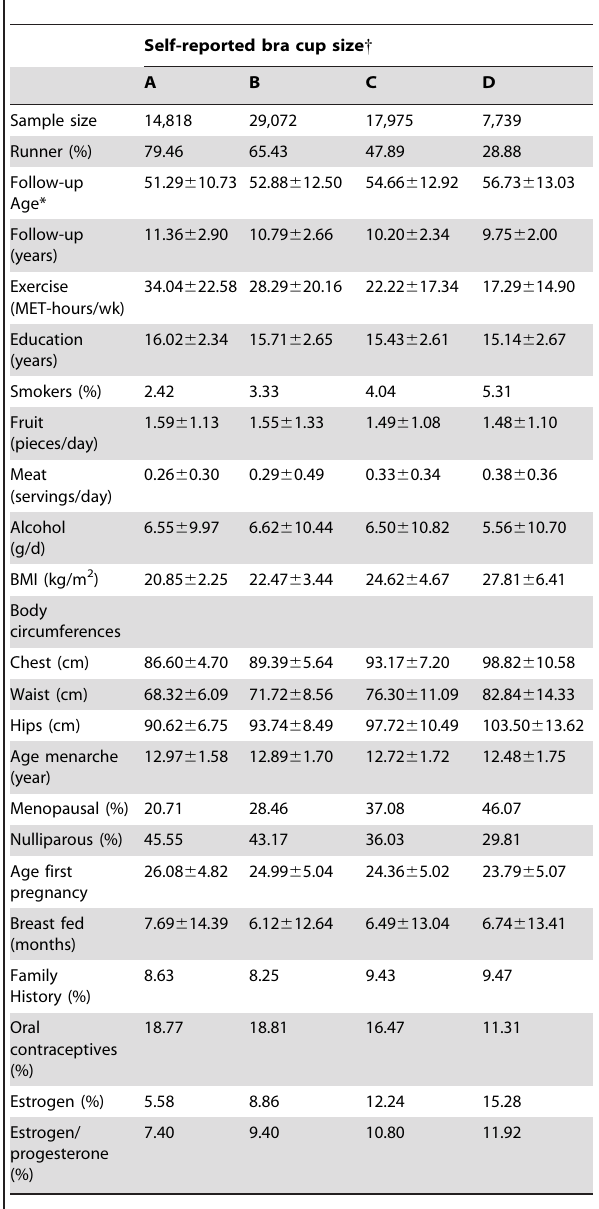
Table 2. Baseline sample characteristics by breast